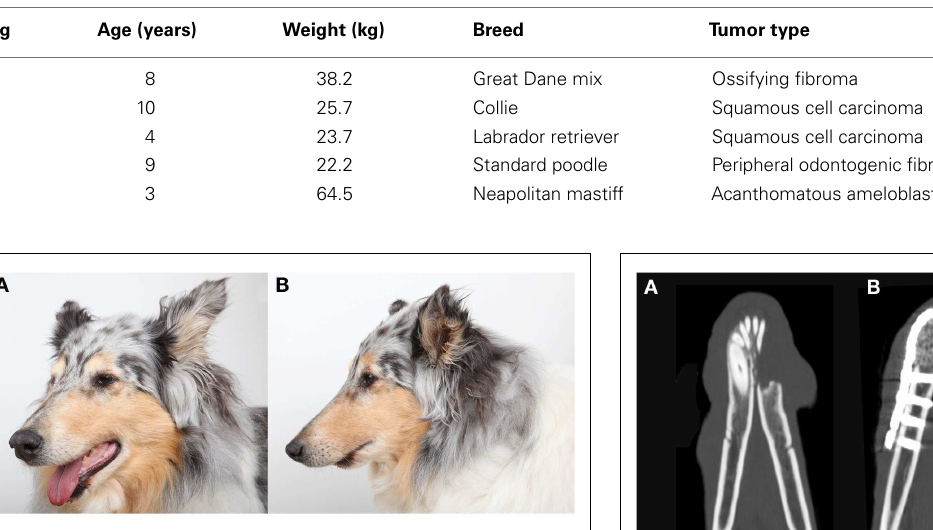
Table 1 | Summary data for five dogs that received rostral mandibular reconstruction .